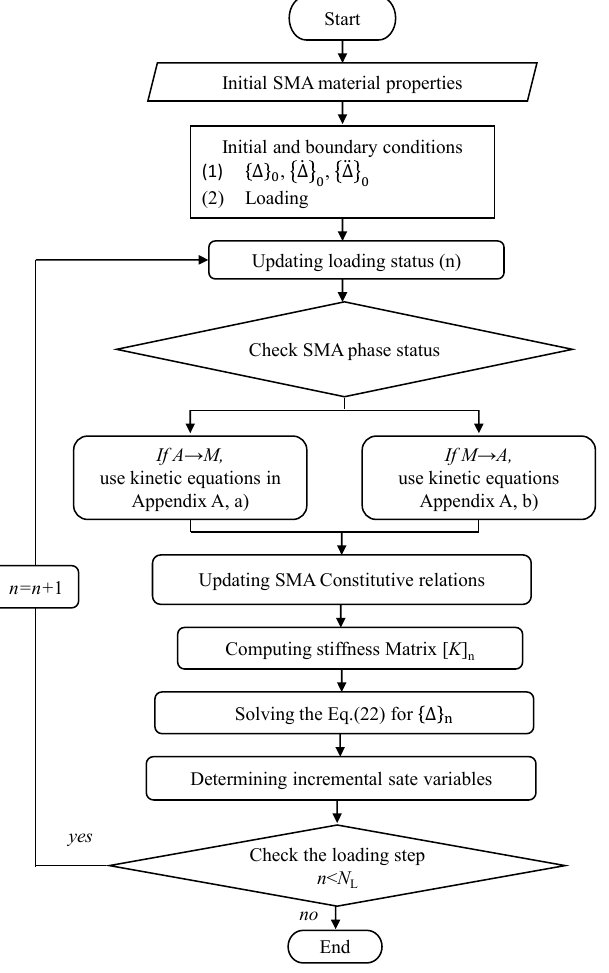
Figure 2. Solution algorithm for the SMAHC plate.